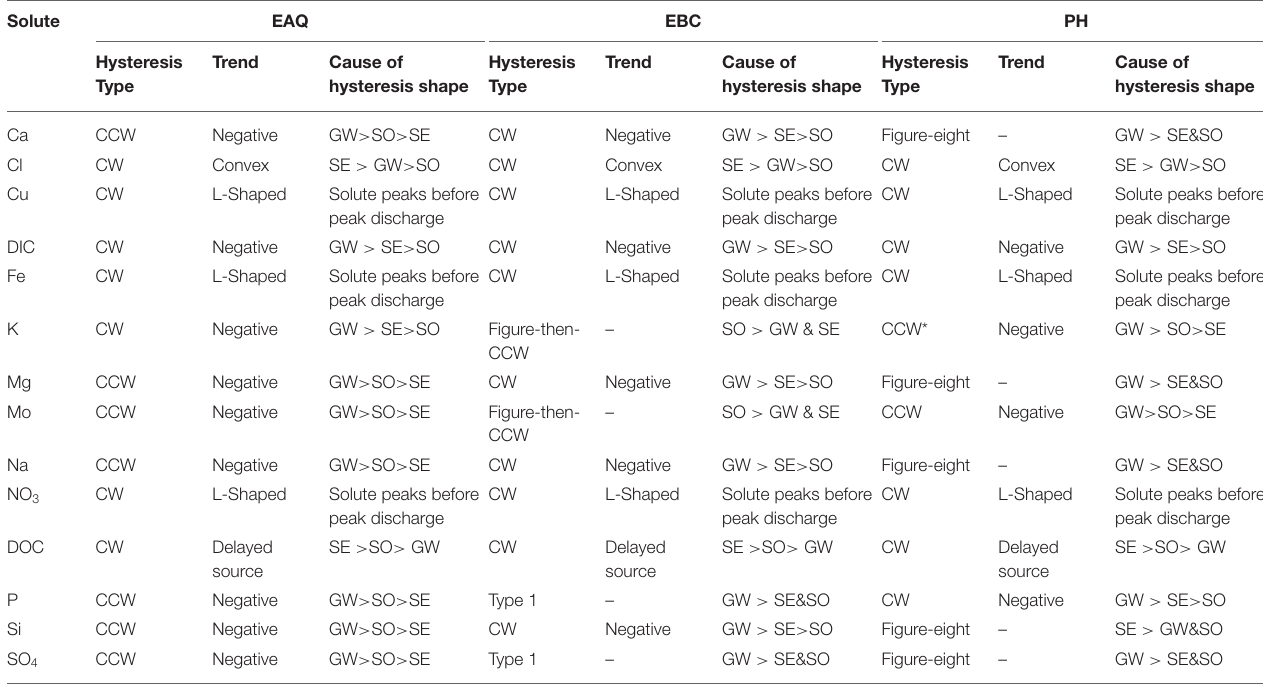
TABLE 4 | Classes of hysteresis in concentration-discharge plots for solutes at all three stations of the East River watershed.